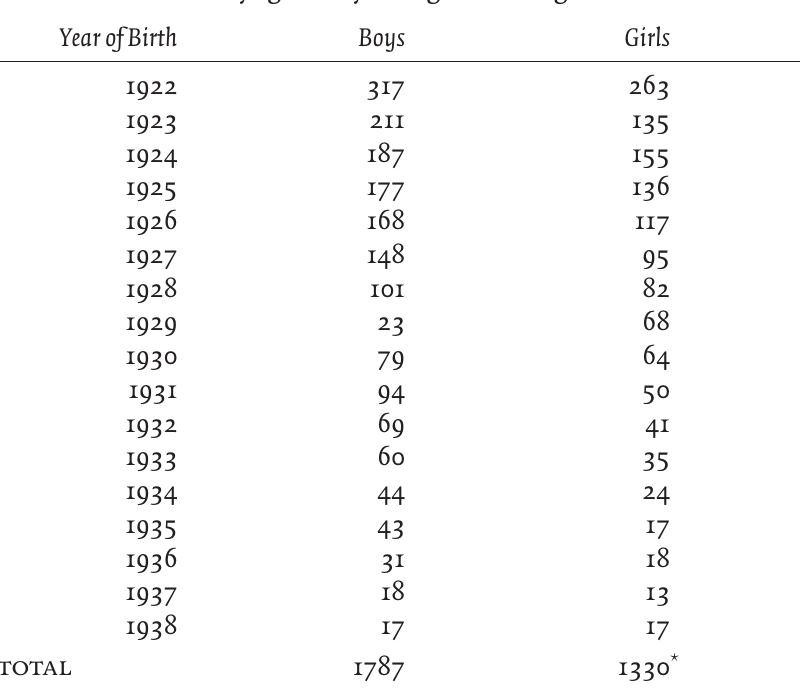
Numbers by age of boys and girls